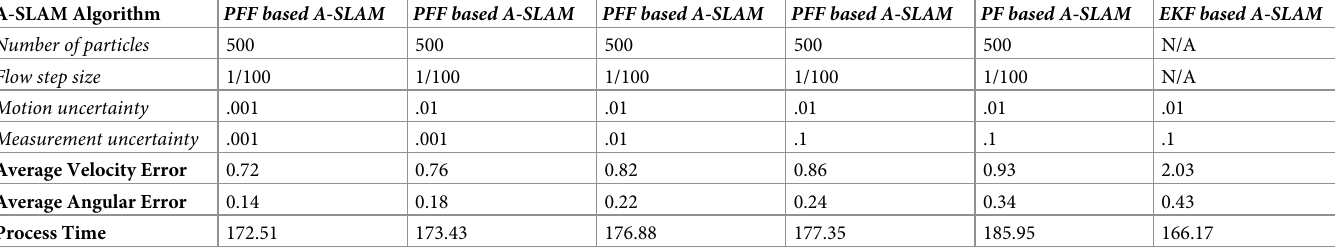
Table 2. Case study 2–comparisons: SLAM methods’ parameters, errors and process